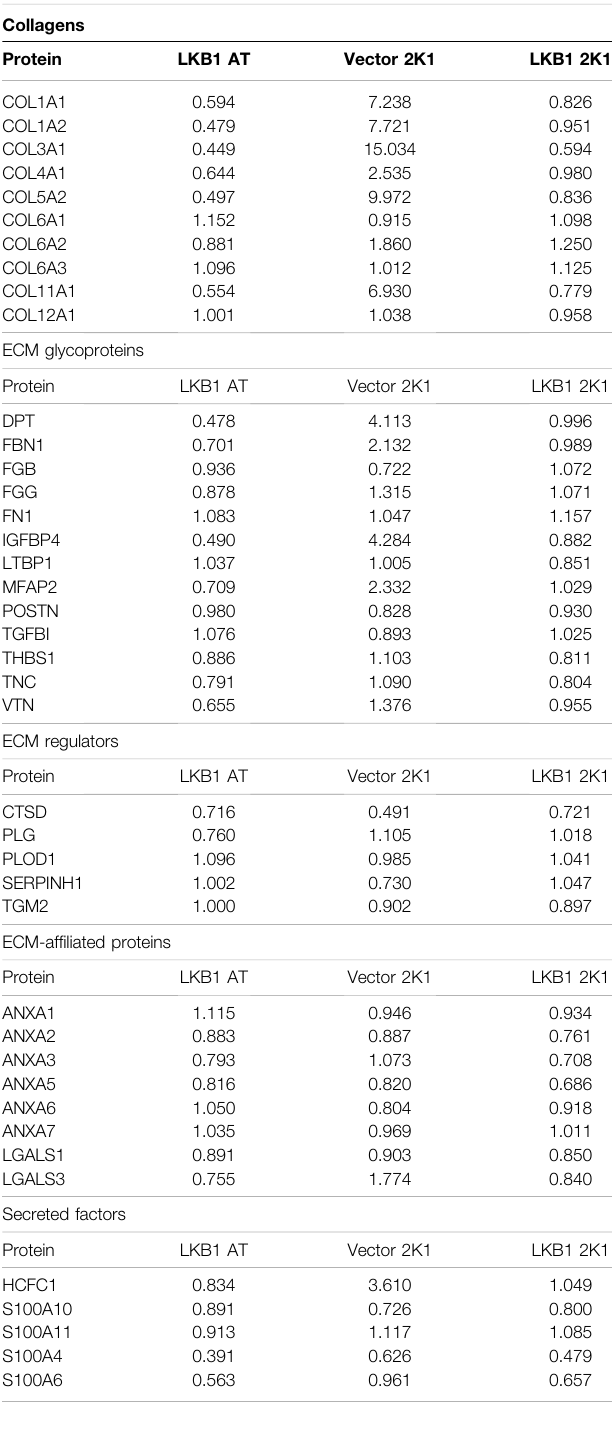
TABLE 1 | ECM proteins altered with seeding of LKB1 on tumor and adipose scaffold. Collagens